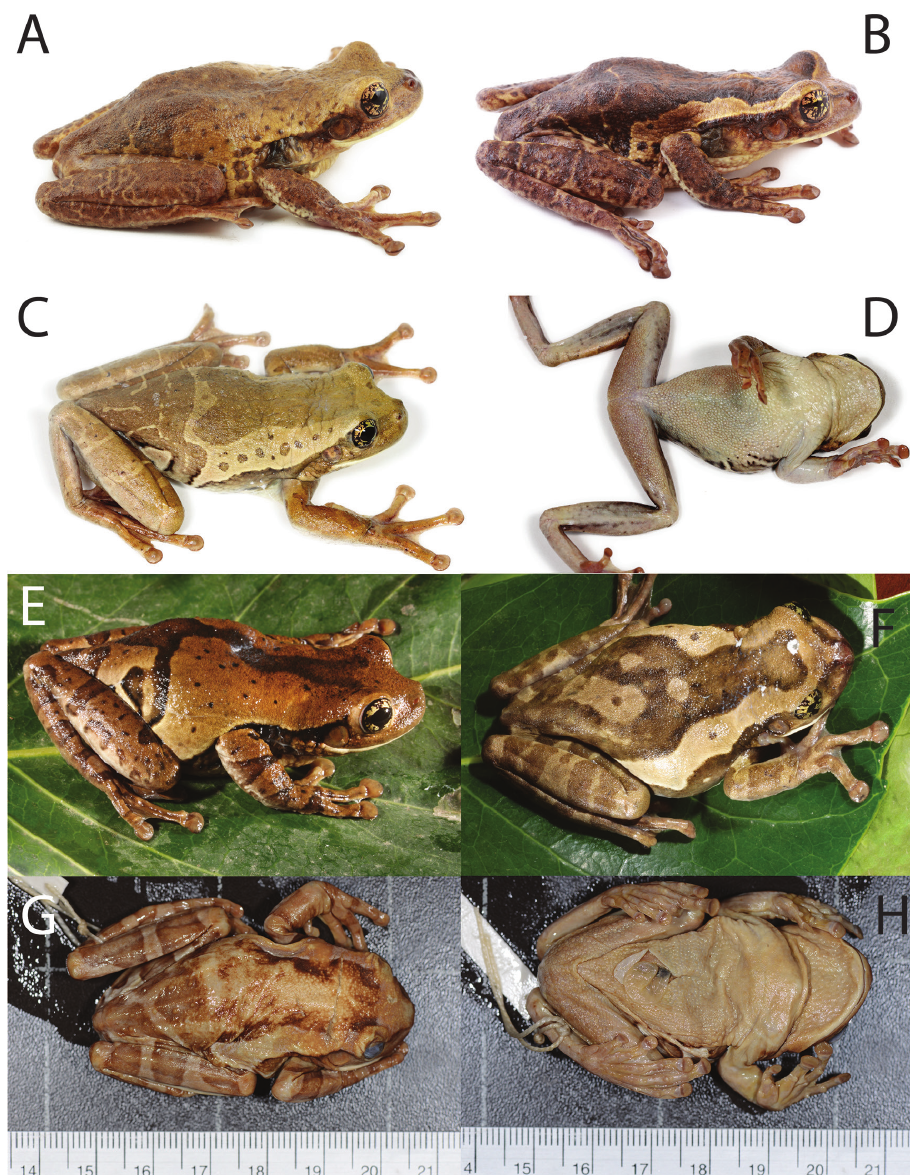
Figure 11. External morphology of Trachycephalus quadrangulum comb. n. from the Chocó region, western Ecuador. A QCAZ 39360, adult male, SVL = 74.1 mm, Caimito, Provincia de Esmeraldas, Ecuador B QCAZ 39361, adult male, SVL = 73.2 mm, same locality as A C–D QCAZ 51746, adult female, SVL = 80.3, Bosque Pacocha, Provincia Manabí, Ecuador E QCAZ 35406, adult male (SVL = 69.5), Bosque Protector Puyango, Provincia El Oro, Ecuador F QCAZ 28530, adult male (SVL = 64.5), Hacienda Santa Teresita, Provincia del Guayas, Ecuador; (G–H) Holotype of Hyla quadrangulum , adult female; scale, in cm, shown for reference. Photographs: A–F by S. R. Ron, G–H by Jeff